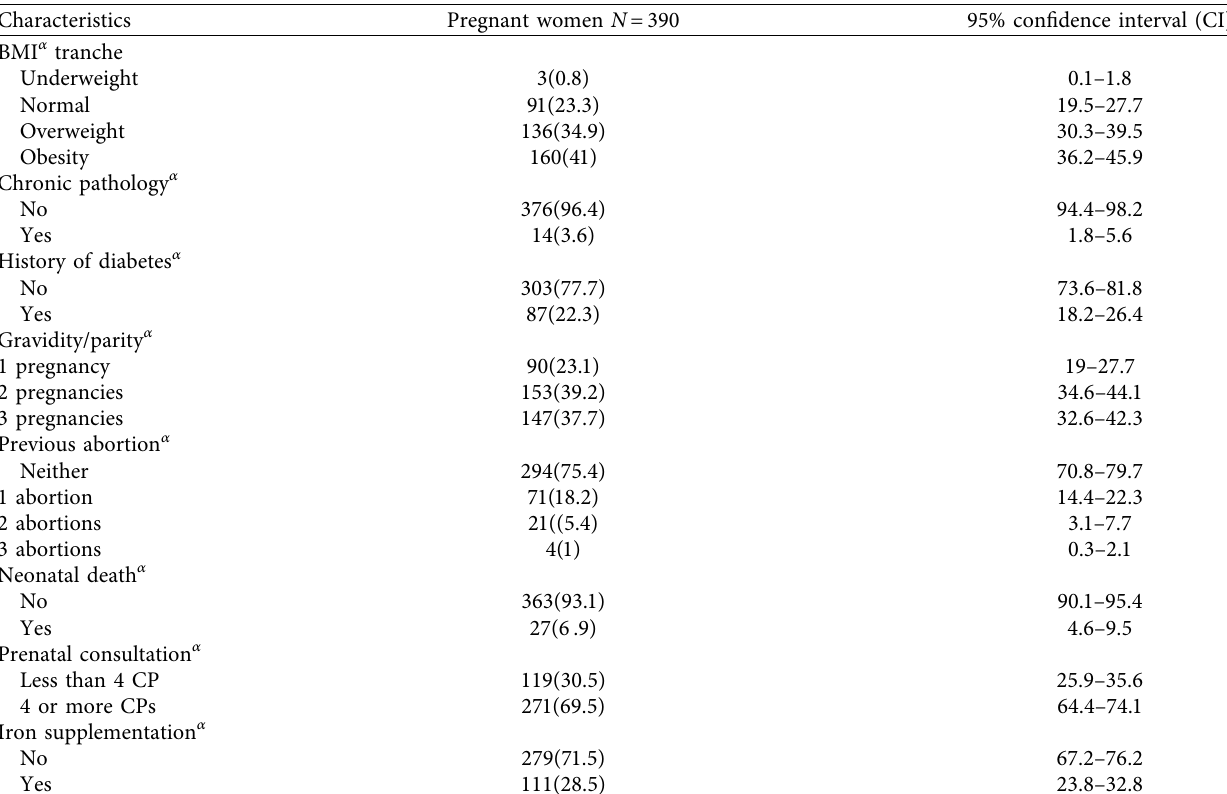
Table 2: Population distribution of female participants by anthropometric information and medical and obstetric history α : values are expressed as number and percentage.